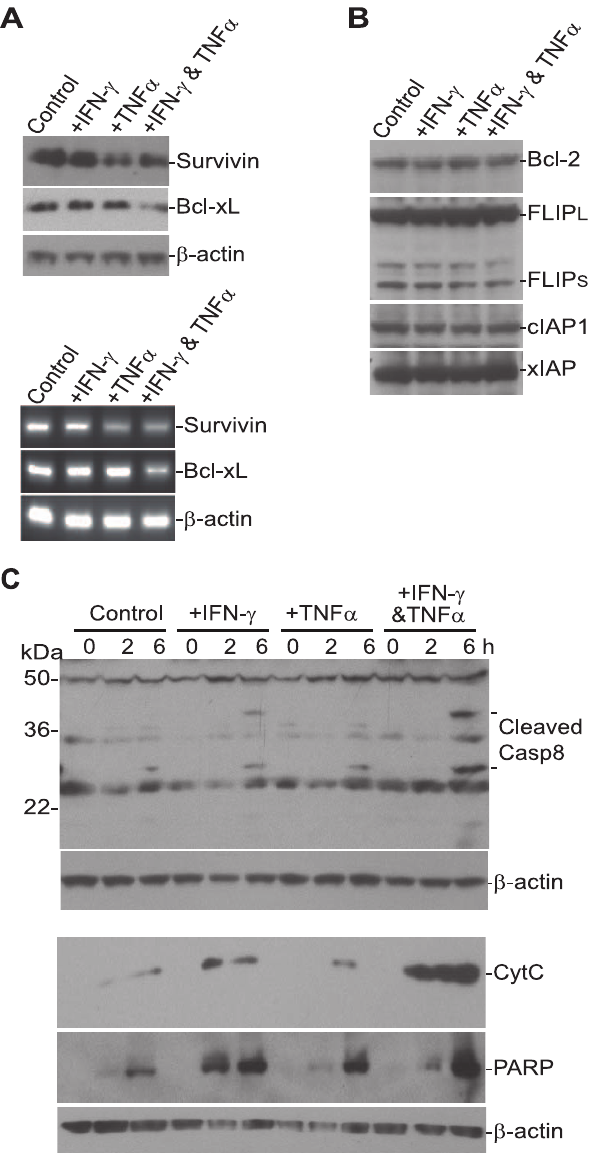
Figure 2. TNF a and IFN- c repress survivin and Bcl-xL expres- sion in metastatic colon carcinoma cells. A . Analysis of survivin and Bcl-xL protein and mRNA level. SW620 cells were treated with IFN- c , TNF a or both IFN- c and TNF a for 24 h. Cells were then analyzed by Western blotting analysis (top panel) for the level of the indicated proteins and by RT-PCR analysis (bottom panel) for mRNA level of the indicated genes. B . Analysis of protein levels of anti- apoptotic genes. Cells were treated as described in A and analyzed by Western blotting analysis for the indicated proteins. C . Caspase activation and apoptosis. SW620 cells were treated with IFN- c , TNF a or both IFN- c and TNF a overnight, followed by incubation with recombinant TRAIL protein (100 ng/ml) for the indicated time. Total cell lysates were then prepared and analyzed by Western blotting for activated caspase 8. Cytosol fractions were also prepared from cells as treated above and analyzed for cytochrome C release and PARP cleavage.